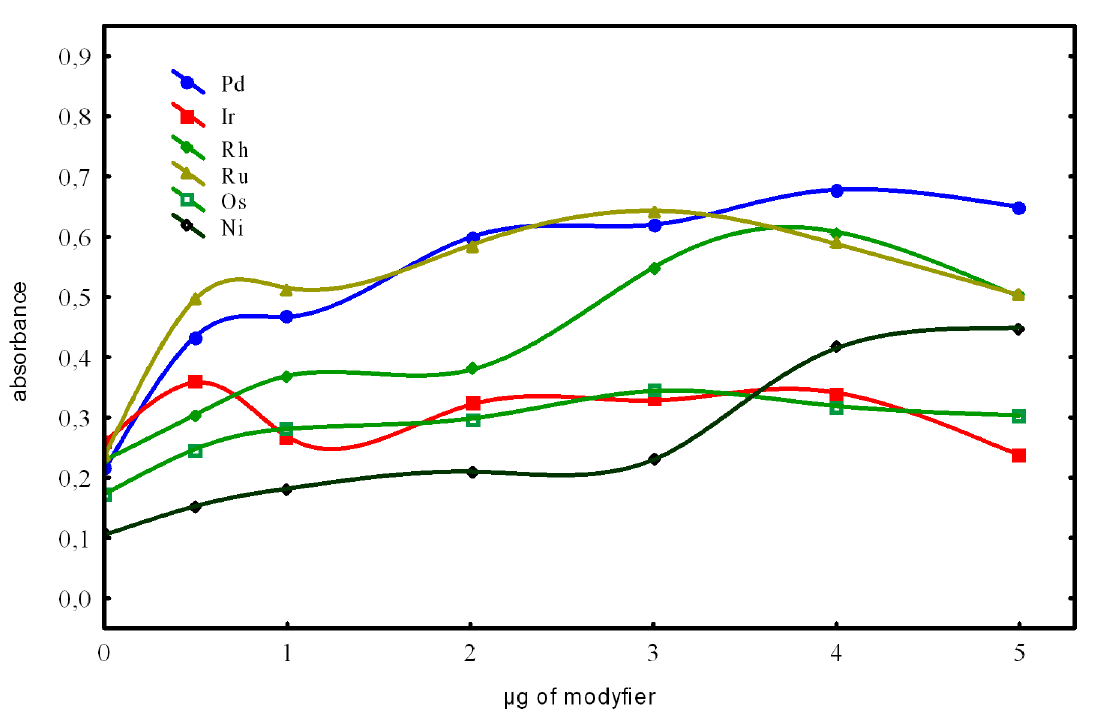
Fig. 2 The analytical signal versus the amount of the modi› er used (10